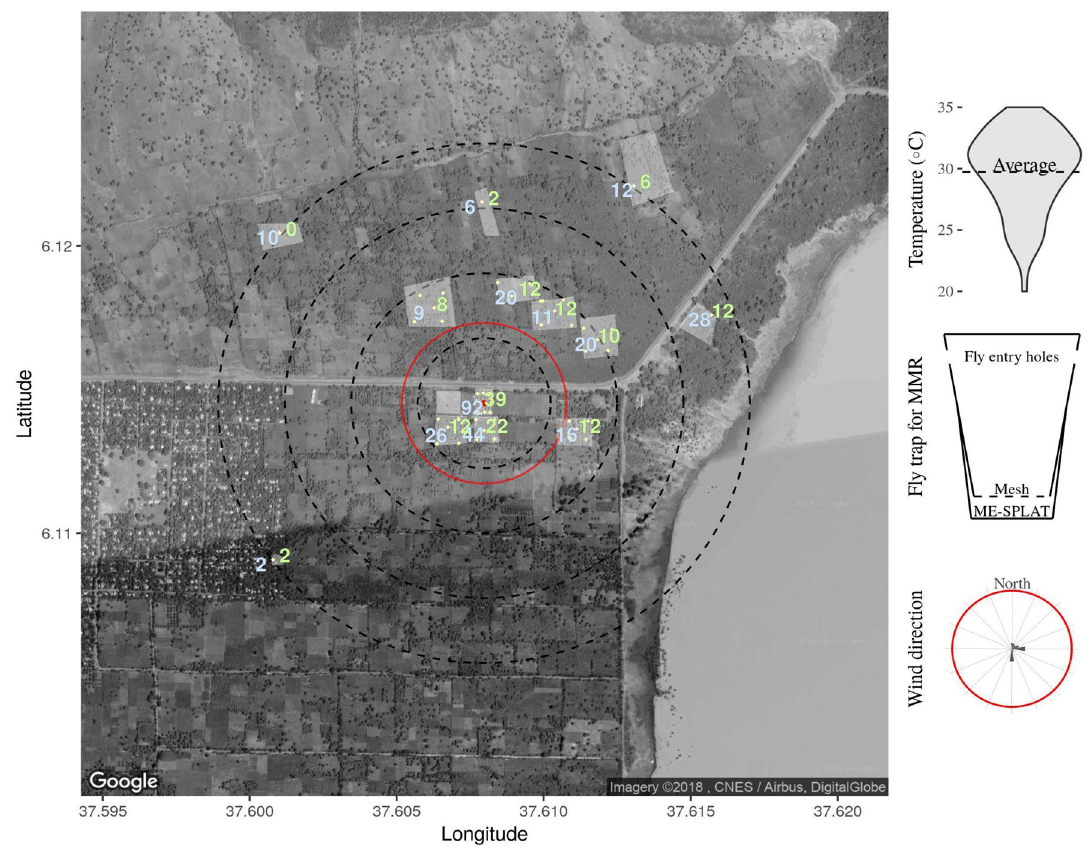
Figure 3. The average number of blue and green-marked male B. dorsalis recaptured per position. Fruit flies were either released 3 days before (green) or after trap set up (blue) from the central position (red dot). Light- shaded areas indicate the perimeters of the smallholder farms in which traps were placed. Concentric dotted circles indicate the distances from the release point (250, 500, 750 and 1000 m). For comparison, the red circle indicates the approximate size of the guava farm in a commercial farm Upper Awash. Note the lake at around 150 m east from the release point. Top inset: violin plot showing the range of temperatures at 12 noon during the observation period with an average temperature in a dashed line. Middle inset: the modified bucket trap for collecting flies for marking. Flies could not reach the methyl eugenol bait. Bottom inset: prevailing wind direction and strength (red line demarcates wind strength between calm and moderate). For visualization purposes a map was produced using the average trap catch average per location and the package ggmap, a wrapper for ggplot2 (Version:3.0.0, URL: http://ggplo t2.tidyv erse.org) was used for accessing the google API and downloading the map for subsequent mapping 28 , temperature and wind data was gathered using the package WeatherData 29 , where a temperature set was filtered for 12:00 h local time. The map was annotated with each of the orchards and trap position and concentric circles representing the distances from release